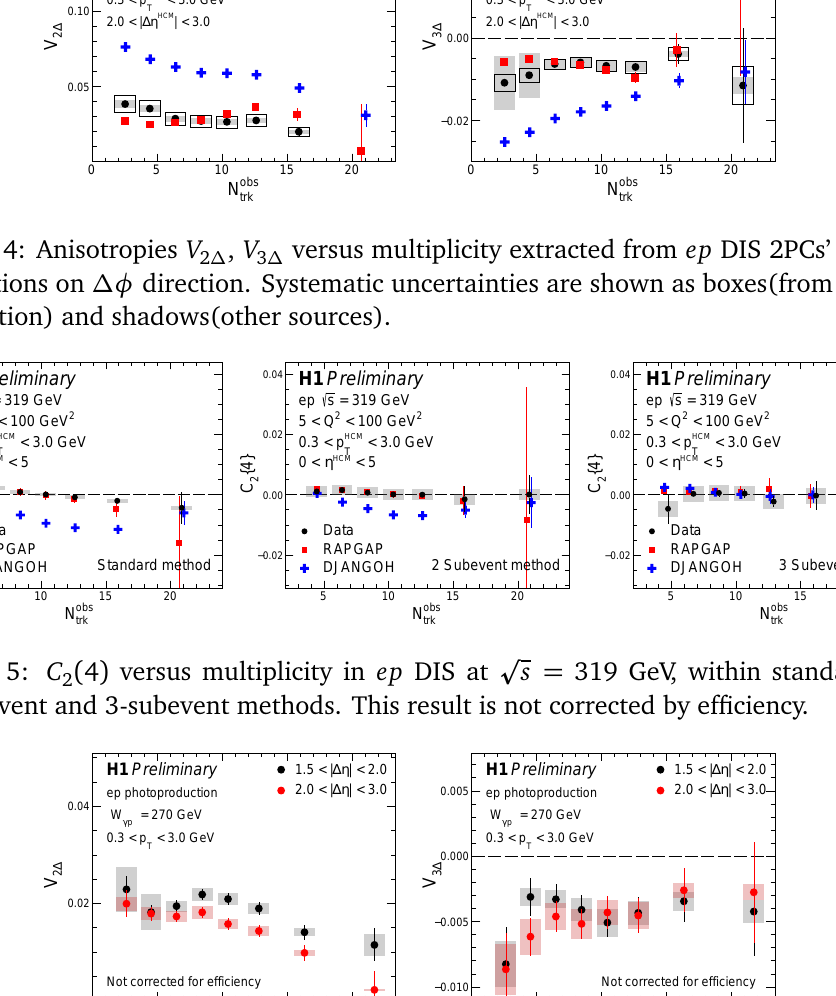
Figure 6: Anisotropies V , V versus multiplicity extracted from ep photoproduc- 2 ∆ 3 ∆ tion 2PCs’ 1-D projections on ∆ φ direction. Systematic uncertainties are shown as shadows.